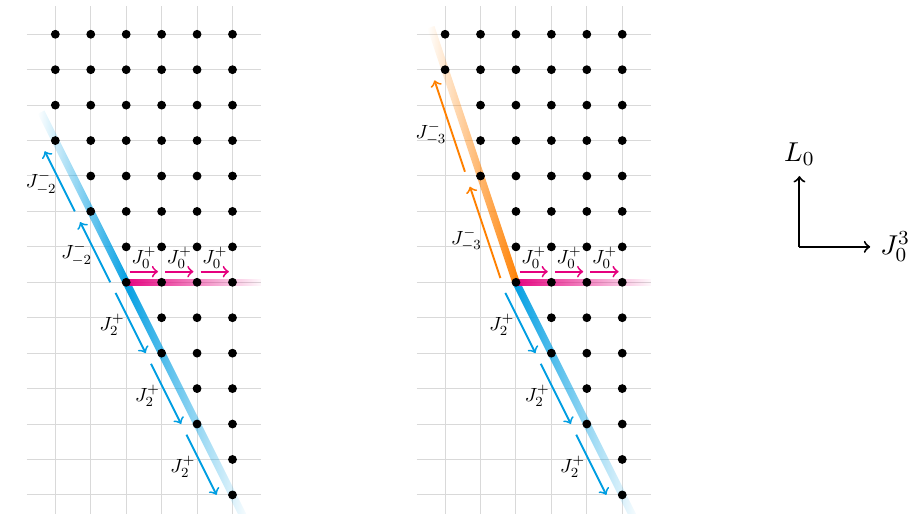
Figure 1 . The schematic form of the Verma module for a continuous representation with w = 2 (left) and a discrete representation with w = 2 (right). Here a black dot signifies the presence of at least one state in the Verma module with the indicated charges. When considering operators ( x ; y ; z ) , the x coordinate resums states on the magenta line, while the y coordinates resums V w j,h states on the cyan line. Notice that the right picture can be equivalently interpreted as the Verma module of a D + representation with w = 2 or as the Verma module of a D − representation with w = 3 , which is a manifestation of eq.